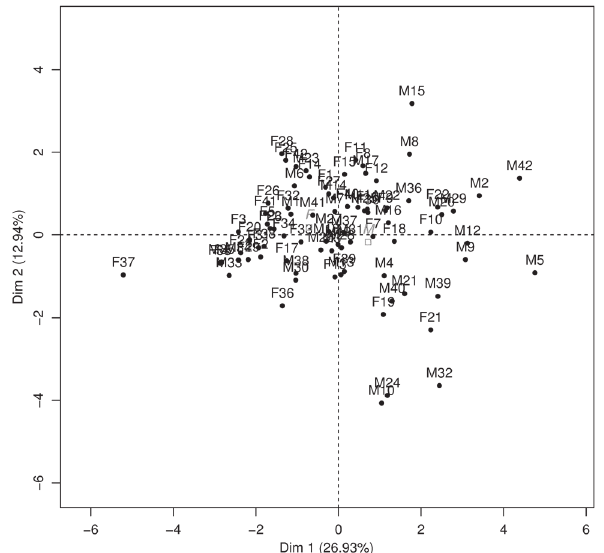
Antwren sexes with all morphometric